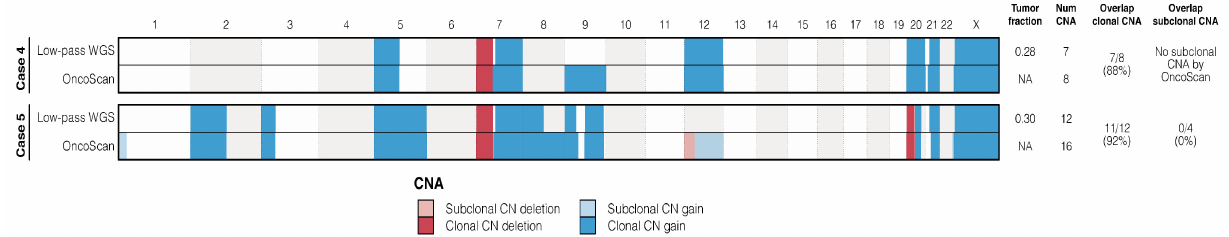
Figure 3. Copy number profile of primary mediastinal large B-cell lymphoma. The first line refers to CNA from cell-free DNA low-pass WGS, followed by the CNA of FFPE Oncoscan. Chromosomes are sorted from 1 to X and p to q (chromosome Y was excluded). Gains and losses are depicted in blue and red, respectively. The subclonal CNA are highlighted by low color